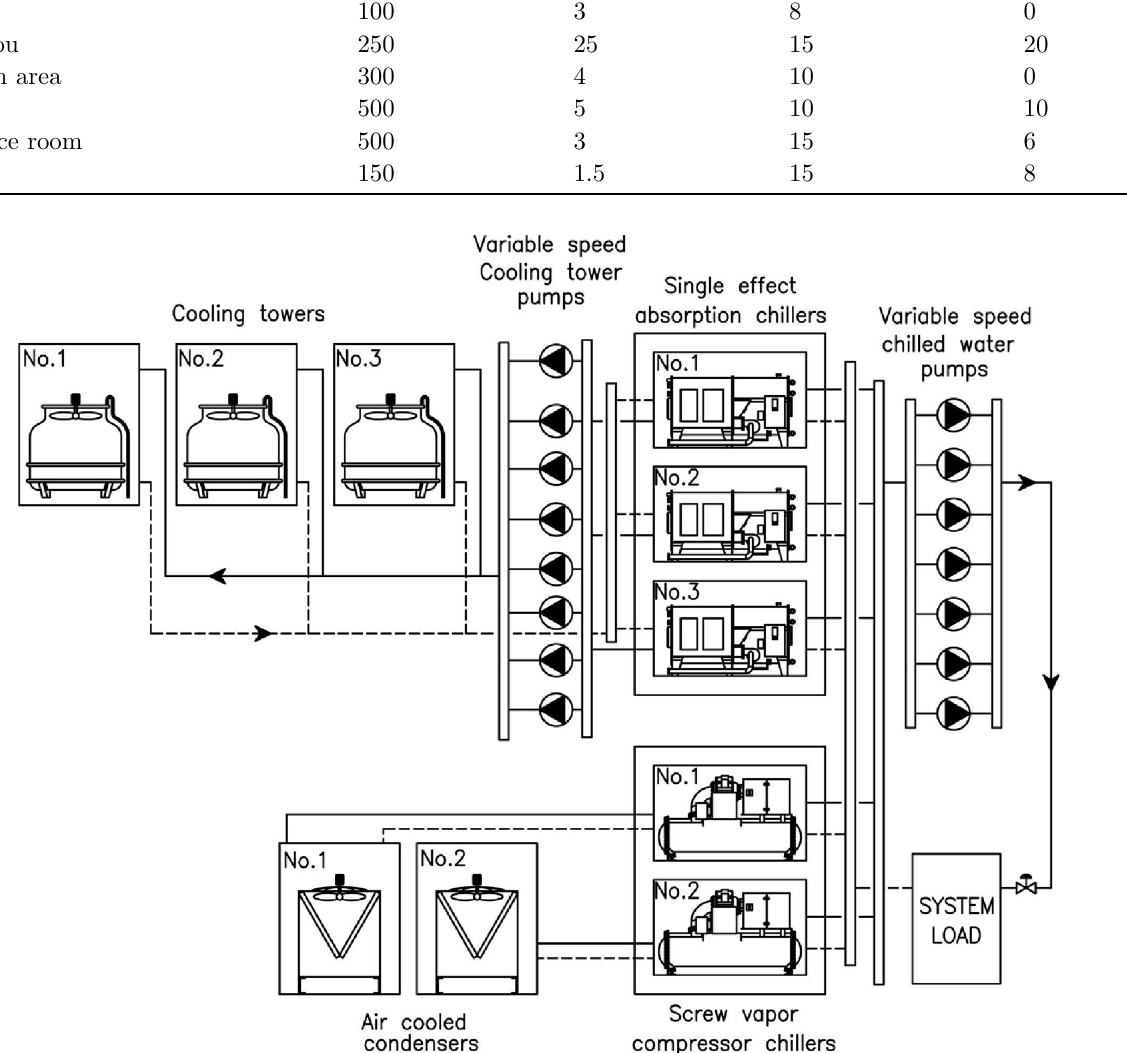
Fig. 1. Schematic diagram of Tehran hospital hybrid chiller plant